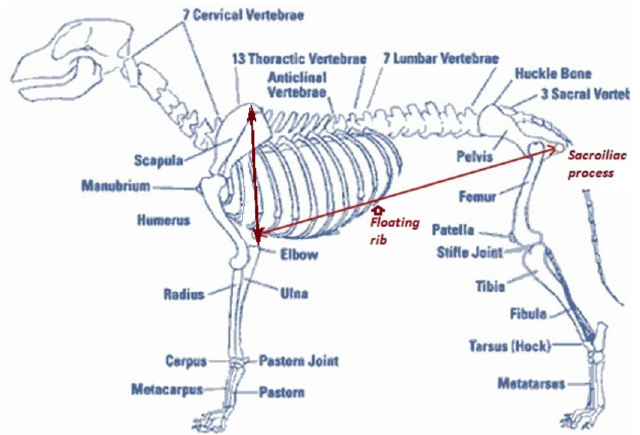
Fig 3. Painted dog ( Lycaon pictus ) skeletal structure demonstrating floating ribs and discrete points from which morphometric measurements to calculate belly score were